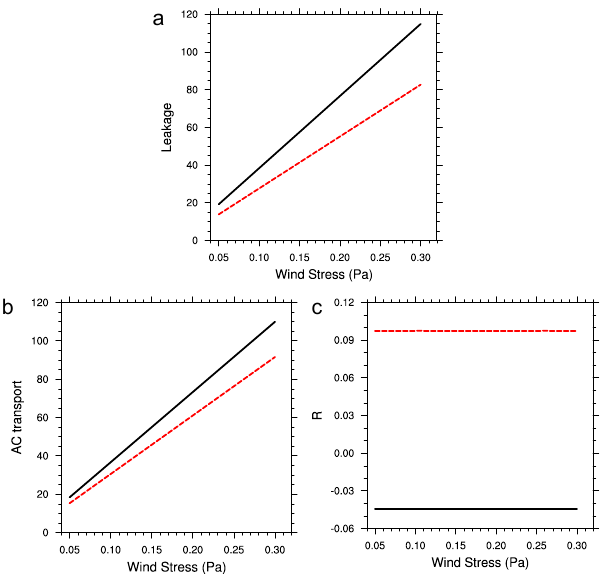
Fig. A2. Agulhas leakage (a) , Agulhas Current transport (b) and retroflection index (c) as a function of wind stress computed from the linear model in cases where the Indonesian Passage is open (black) and closed